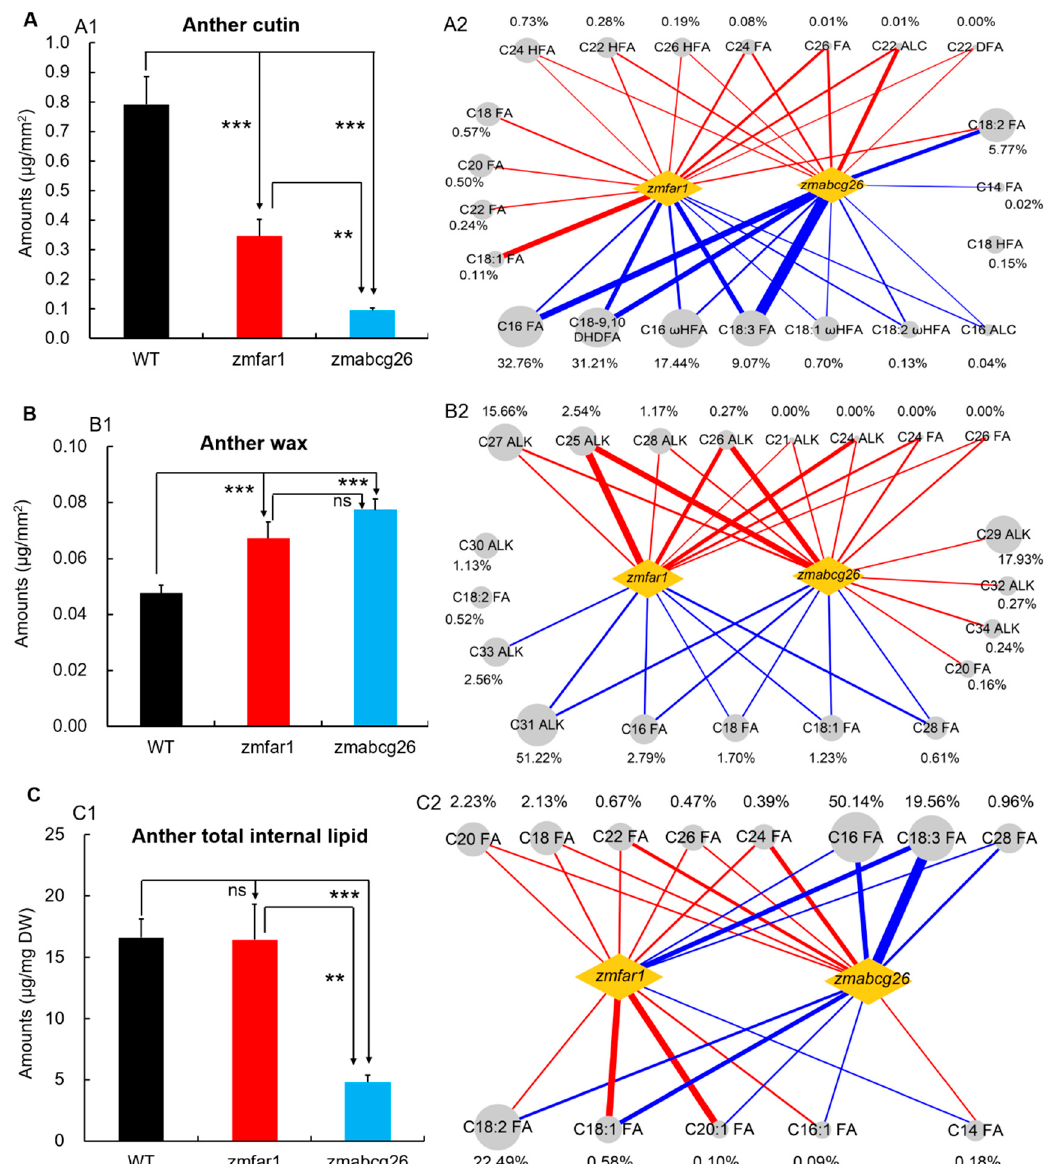
Figure 6. Comparison of genes ZmFAR1 and ZmABCG26 for lipid metabolism of maize anthers by lipidomics analysis: ( A ) the amount of anther cutin in WT and mutants zmfar1 and zmabcg26 at stage 13: ( A1 ) the total amount of anther cutin per unit surface area; ( A2 ) the changes of 21 specific cutin monomers in zmfar1 and zmabcg26 anthers, compared to those in the WT anther at stage 13; ( B ) the amount of anther wax in WT and mutants zmfar1 and zmabcg26 at stage 13: ( B1 ) the total amount of wax per unit surface area; ( B2 ) the change range of 20 specific wax constituents in zmfar1 and zmabcg26 anthers at stage 13, compared to those in WT; ( C ) the number of internal lipid constituents in WT and mutants zmfar1 and zmabcg26 at stage 13: ( C1 ) the total amount of internal lipid constituents per unit dry weight; ( C2 ) the change range of 13 specific internal lipid constituents in zmfar1 and zmabcg26 anthers at stage 13, compared to those in WT. In Figure 6(A1,B1,C1), ** and *** indicate the significant levels of 1% and 1‰ (Student’s t test, n = 3), respectively. In Figure 6(A2,B2,C2), the red or blue lines represent the increase or decrease of the cutin, wax, and internal lipid monomers in mutant anthers, respectively. The thickness of the lines represents the change magnitude of the increase or decrease.